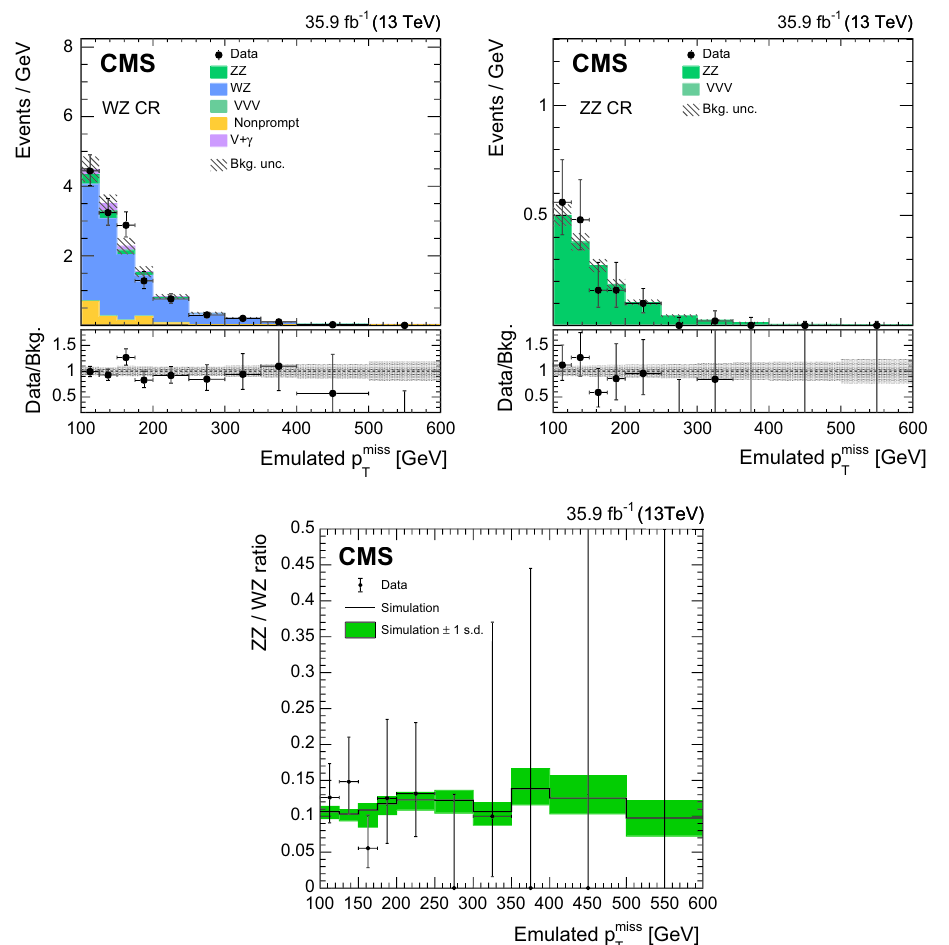
> 500GeV in either channel. Uncertainty bands corre- emulated p miss T spond to the combined statistical and systematic